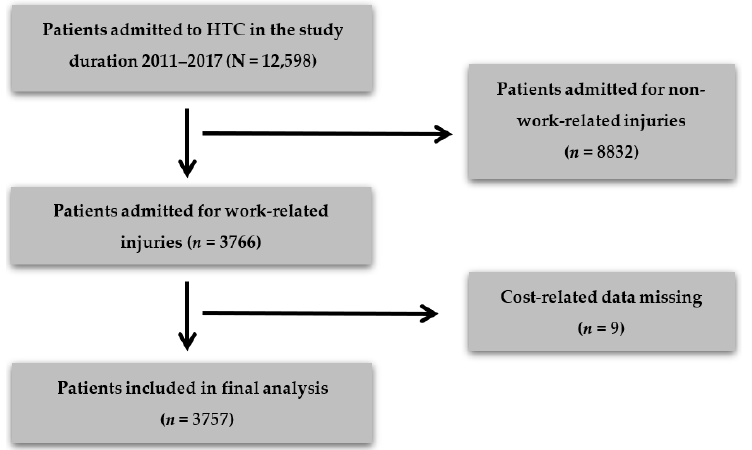
Figure A1. Patient data flowchart, Trauma Registry, Hamad Trauma Center, Doha, Qatar